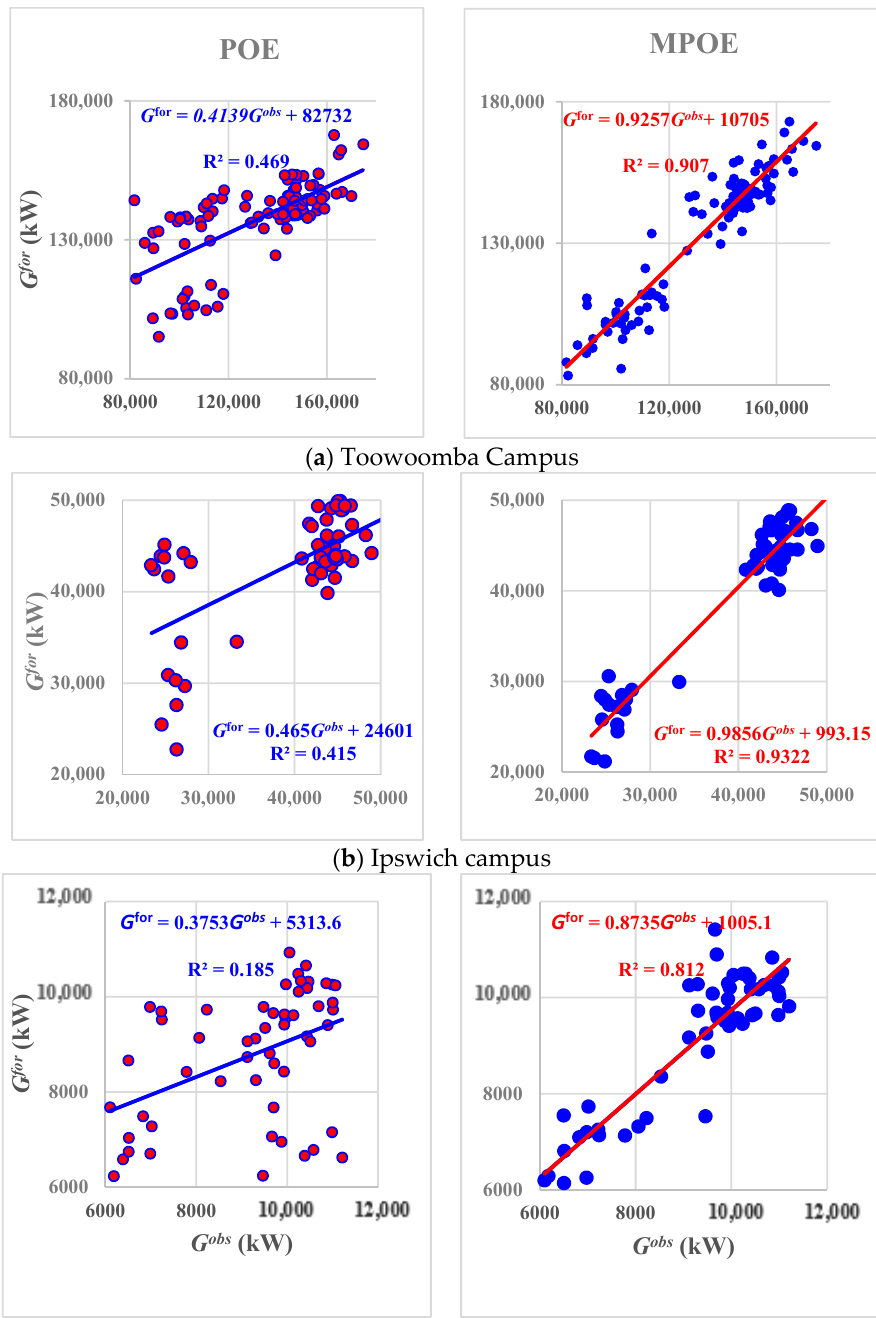
Figure 6. Scatterplots of the observed and forecasted G data in the testing phase with the optimal models of POE and MPOE. Equations of linear regression and the coefficient of determination are incorporated. ( a ) Toowoomba Campus. ( b ) Ipswich campus. ( c ) Springfield campus. Using boxplots (Figure 7) and all station datasets, the MPOE and POE models were compared based on their 25%, 50% and 75% quartiles (lower, middle, upper line of box) as well as maximum and minimum values of the forecasted error statistic |𝐹𝐸| = |𝐺 (cid:3036)(cid:3033)(cid:3042)(cid:3045) − 𝐺 (cid:3036)(cid:3042)(cid:3029)(cid:3046) | . Consequently, the statistical error criteria generated for the MPOE model were significantly lower than those for POE.